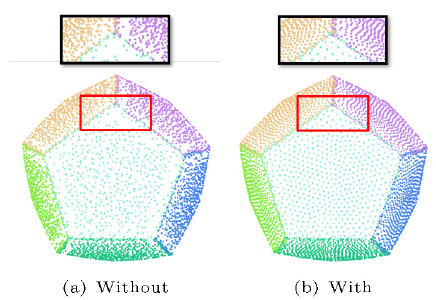
Fig. 16 Filtered results without and with the repulsion term.